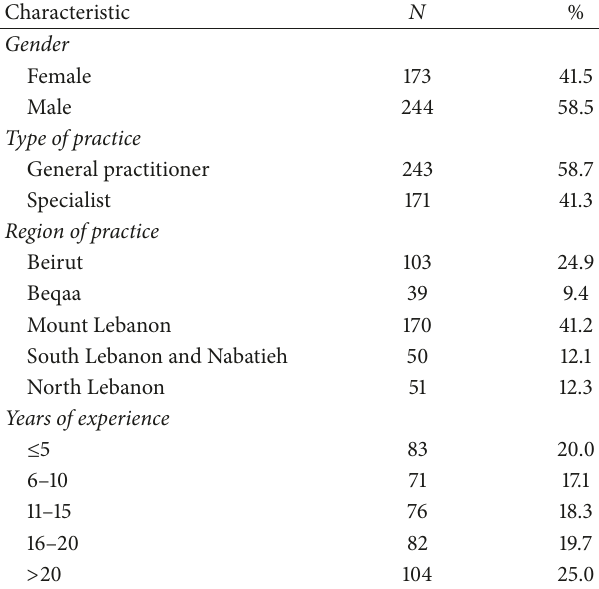
Table 1: Sociodemographic and professional distribution of the surveyed dentists in private dental clinics in Lebanon (2015). The difference in the total number of respondents for each variable is due to missing data in the filled-out questionnaire